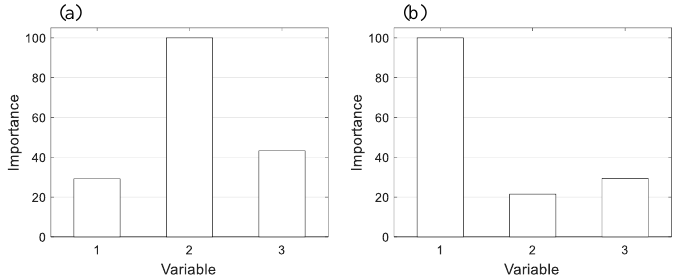
Figure 5. (Nonlinear process) Variable importance values obtained through Method 1: ( a ) Case 1 ( t fault start = 201 and t fault = 300); ( b ) Case 2 ( t fault start = 171 and t fault = 270). fault end end